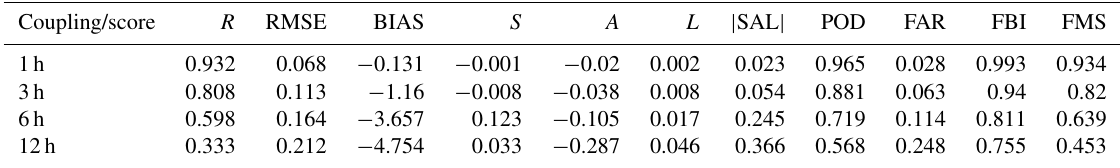
Coupling/score R